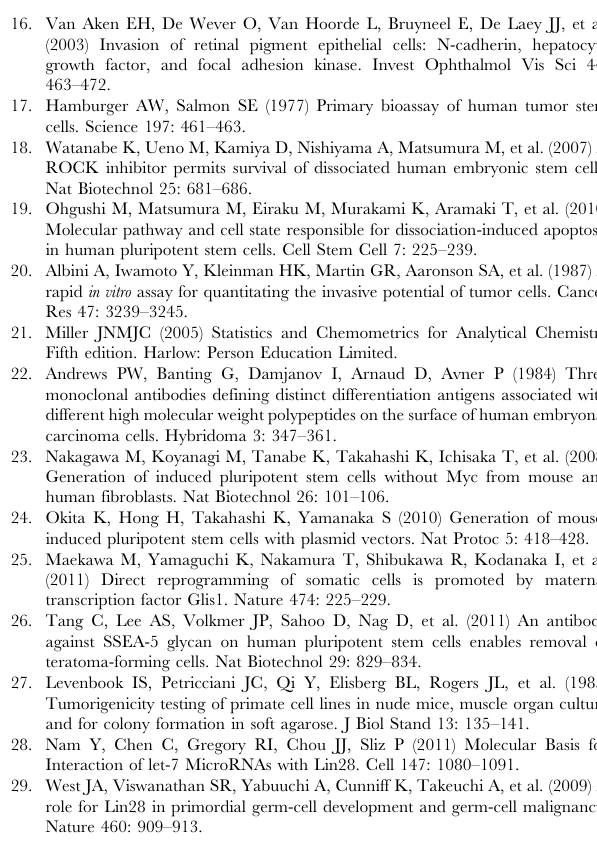
Figure S2 Flow cytometry analysis of spiked hiPSCs cells in primary RPE. CFDA-stained hiPSCs (1%, 2,500 cells; 0.1%, 250 cells; 0.01%, 25 cells) were spiked into primary RPE (2.5 6 10 5 cells) and 1 6 10 5 cells were analyzed by flow cytometry. The numbers indicate the quantity of cells contained in the gate. Table S1 Probes and primers for